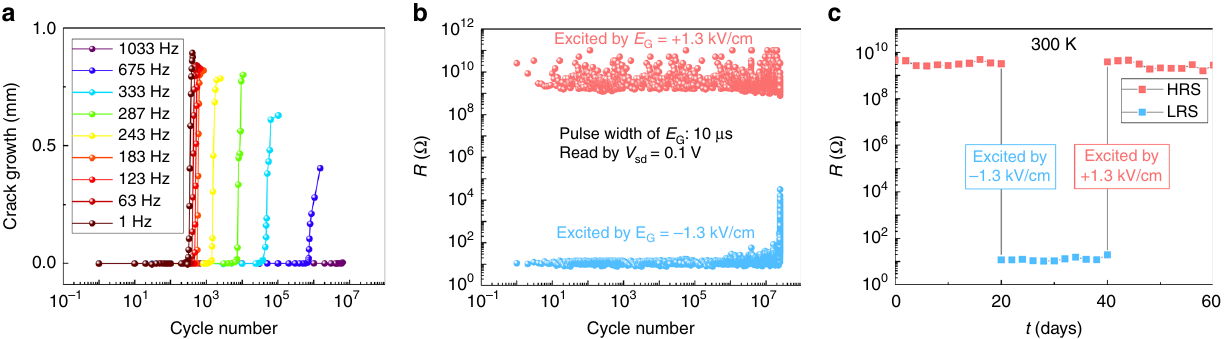
Fig. 4 Crack growth dynamics and endurance testing. a Crack growth length vs. electric cycling number under different cyclic fi eld frequencies. The amplitude of the cyclic electric fi eld with triangular waveform is 1.3 kV/cm. b Two-probe resistance measured by 0.1 V vs. gate electric fi eld pulse number across a single crack. The pulses are of 10- μ s width and the amplitude is 1.3 kV/cm. c Retention of different resistance states of a single crack up to resistance measurements. Upon applying ± 1.3 kV/cm and 10- μ s